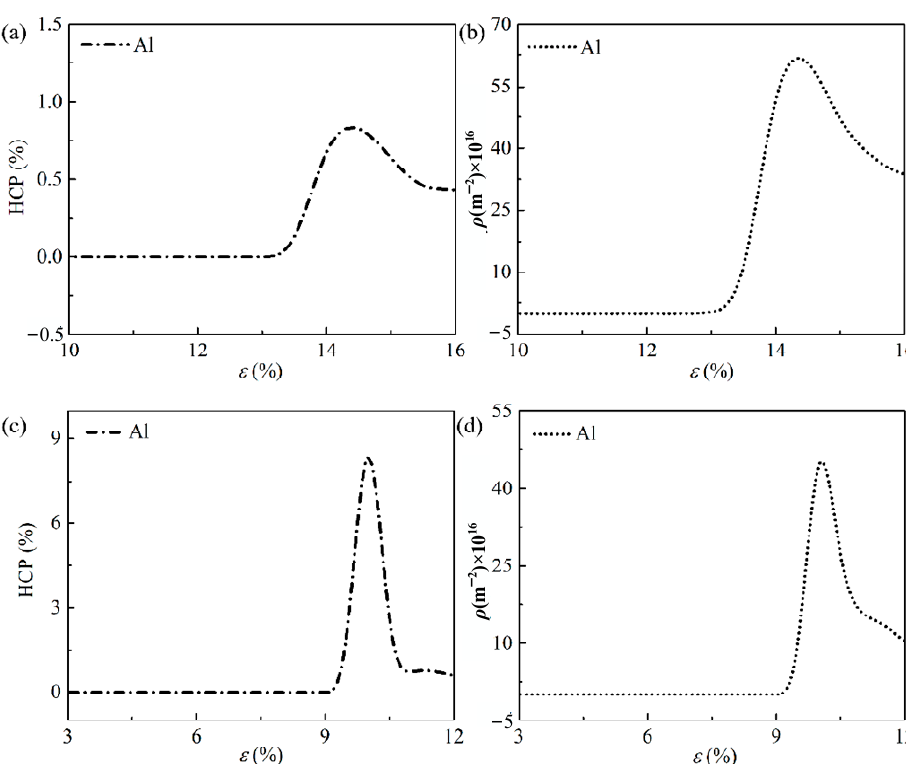
Figure 7. HCP atom percentage and dislocation density analysis of pure aluminum under different loading. ( a , b ) Tensile loading; ( c , d ) Compression loading. loading. ( a , b ) Tensile loading; ( c , d ) Compression